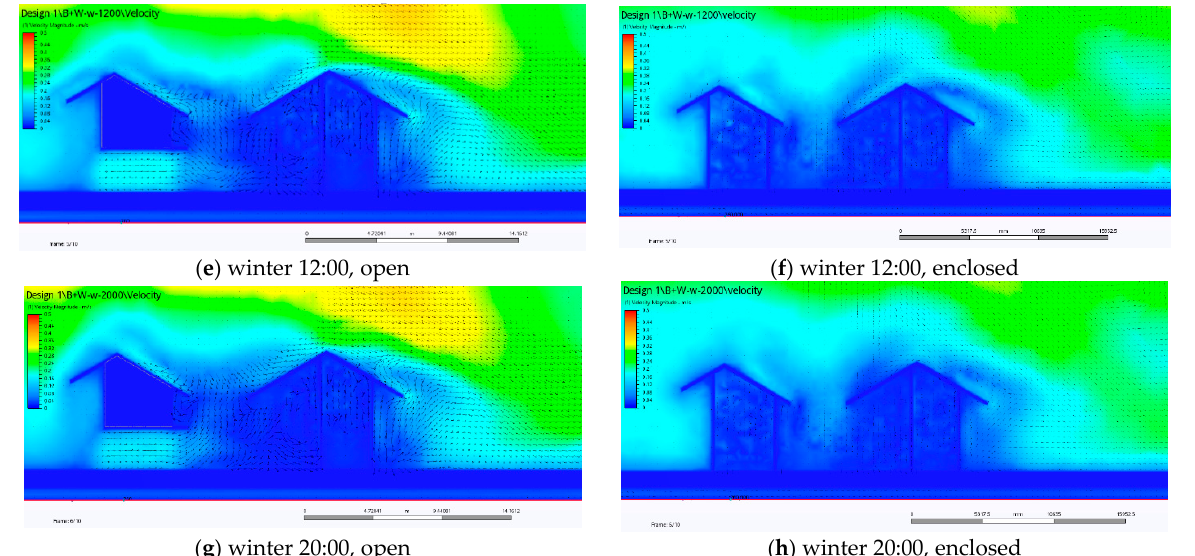
Figure 25. Airflow patterns and wind velocity distributions by both wind and buoyancy effects: ( a – d ) summer scenarios, and ( e – h ) winter scenarios . Energies 2019 , 12 , x FOR PEER REVIEW